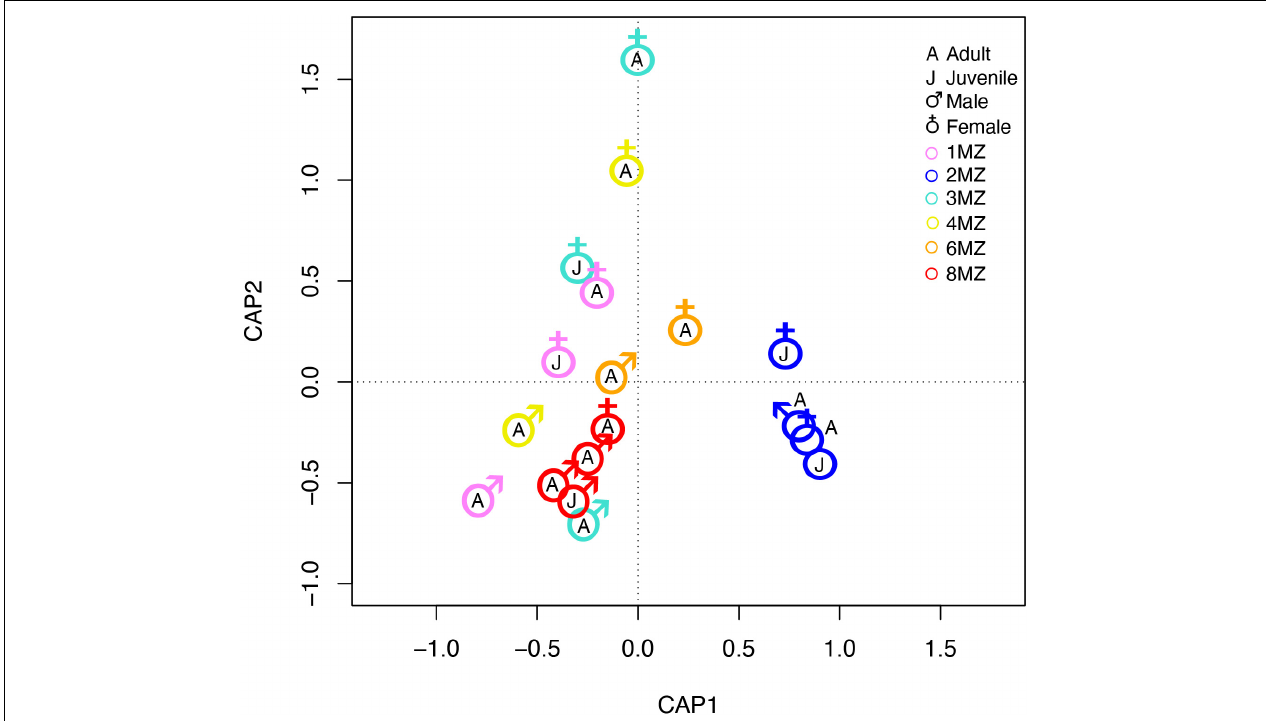
FIGURE 5 | Constrained analysis of principal coordinate ordination plot on bacterial communities of indris fecal